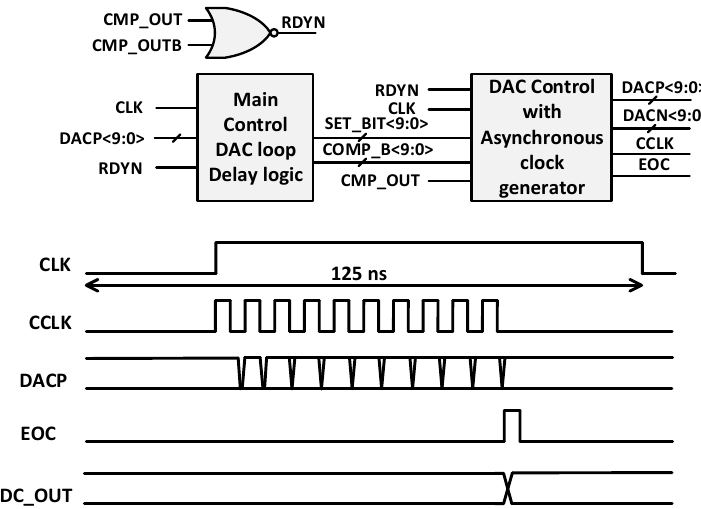
Figure 4. A block diagram of asynchronous control logic and its timing diagram. Electronics 2020 , 8 , x FOR PEER REVIEW